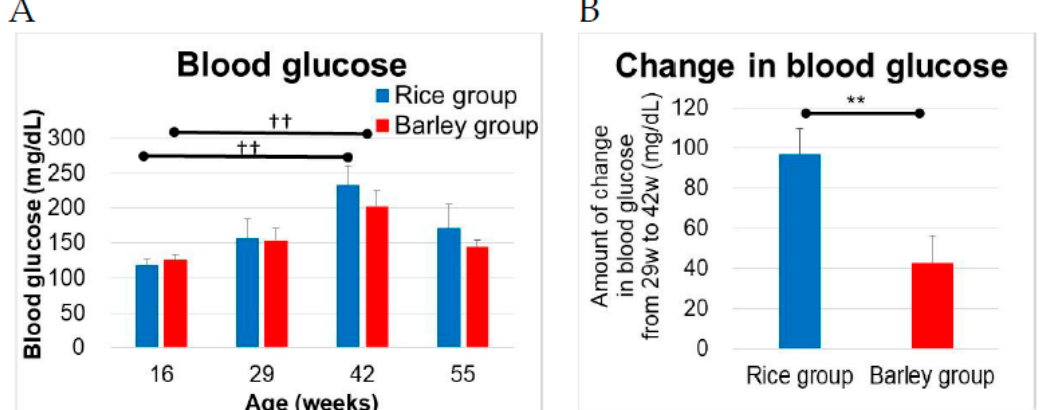
Figure 3. Changes in blood glucose in SAMP8 mice consuming rice or barley diets: ( A ) Levels of blood glucose at 16, 29, 42, and 55 weeks old; ( B ) amount of change in blood glucose from 29 to 42 weeks old. The blood glucose in both groups increased with age from 16 to 42 weeks old. The blood glucose levels of one mouse in the rice group and one mouse in the barley group of age 42 weeks, as well as one mouse in the rice group of age 55 weeks were over the limit of detection and were therefore set at 500 mg/dL. ††; p < 0.01; within group comparison at 29, 42, 52 weeks old vs. at 16 weeks old by Dunnett test. ** p < 0.01; rice group vs. barley group by unpaired t -test.